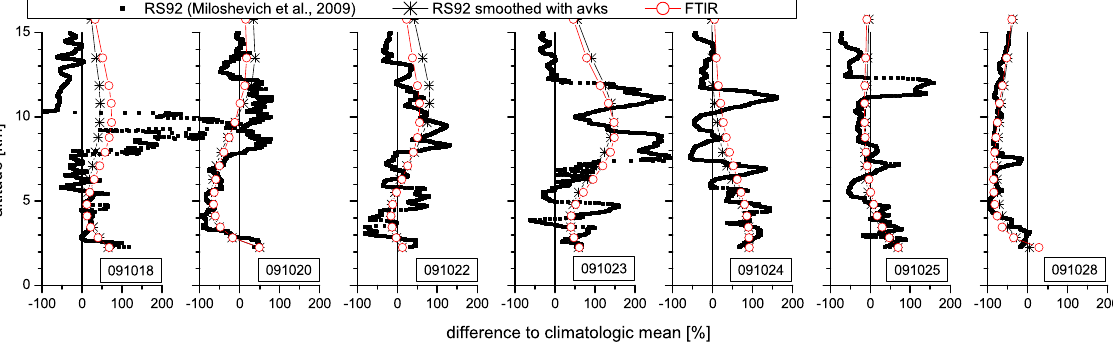
Fig. 11. Comparison of the seven coincident FTIR and Vaisala RS92 H 2 O measurements made during MOHAVE-2009 (18th, 20th, 22nd, 23rd, 24th, 25th, and 28th of October 2009). Profiles are presented as percentage difference to a subtropical climatological profile, FTIR profiles are for a retrieval in the 2650–3180cm − 1 region. Black squares: RS92 data corrected by the Miloshevich et al. (2009) method; Black stars: RS92 smoothed with FTIR averaging kernels; Red circles: FTIR.